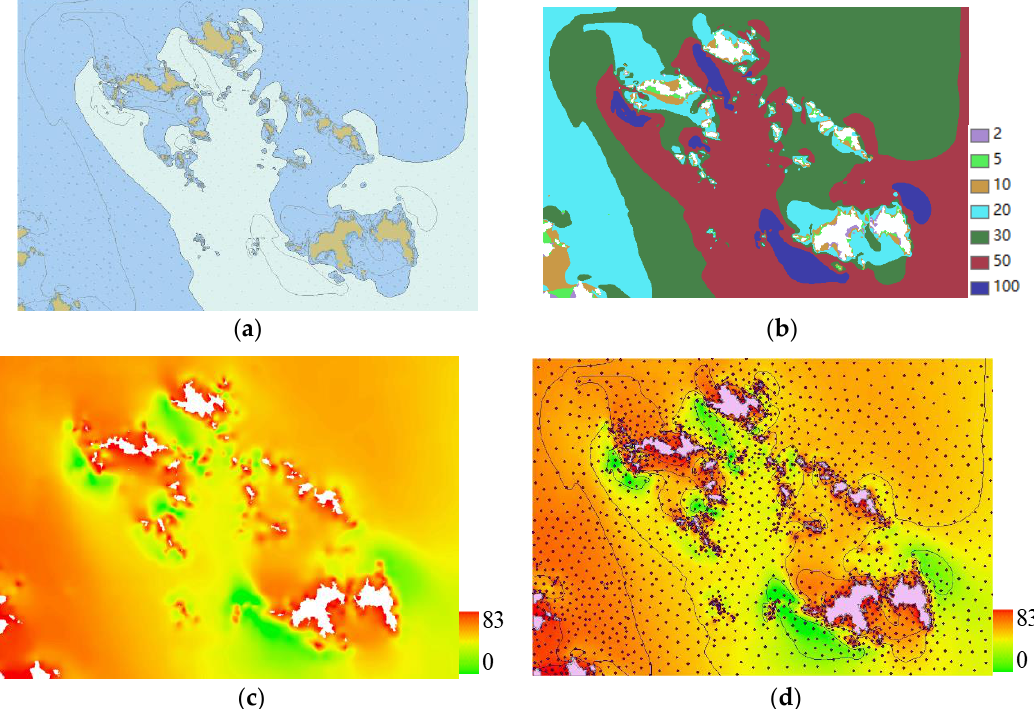
Figure 5. Electronic navigation Chart and Grid Depth Distribution Map. ( a ) S57 Vector Electronic navigation Chart displayed by S52 Standard in the study area; ( b ) Isobath Area Map; ( c ) Depth Distribution Map obtained by spline function interpolation approach with obstacles, in which the blank area is an obstacle; ( d ) Overlay with discrete depth points, contours, islands and reefs and other obstacles. In the depth distribution map, the magenta area is an obstacle.